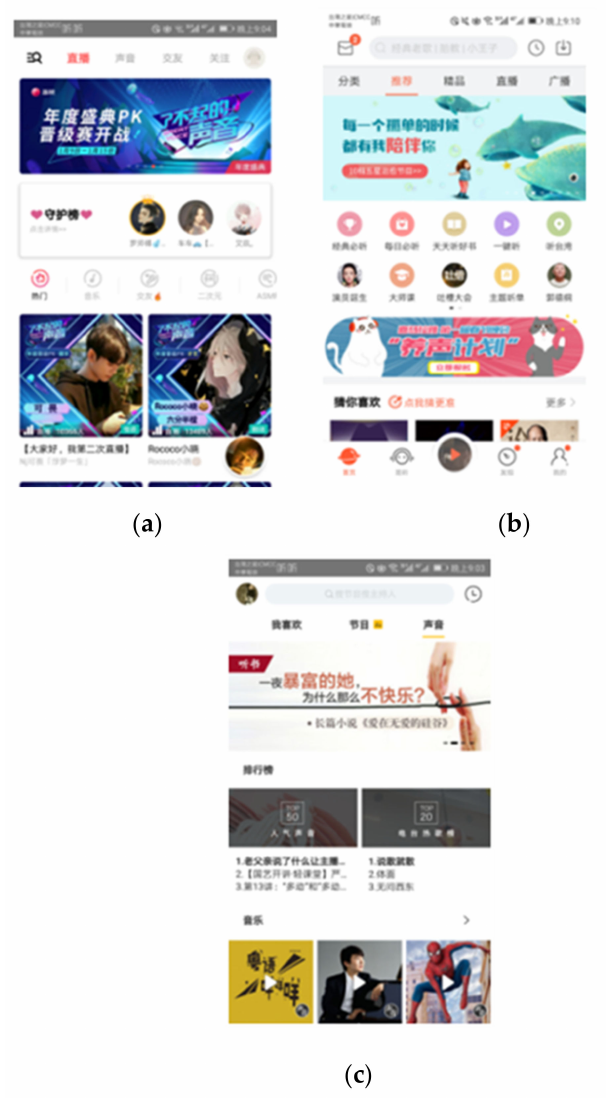
Figure 2. Three user interface designs of the FM touch screens: ( a ) Litchi type; ( b ) Himalaya type; ( c ) Archimedes